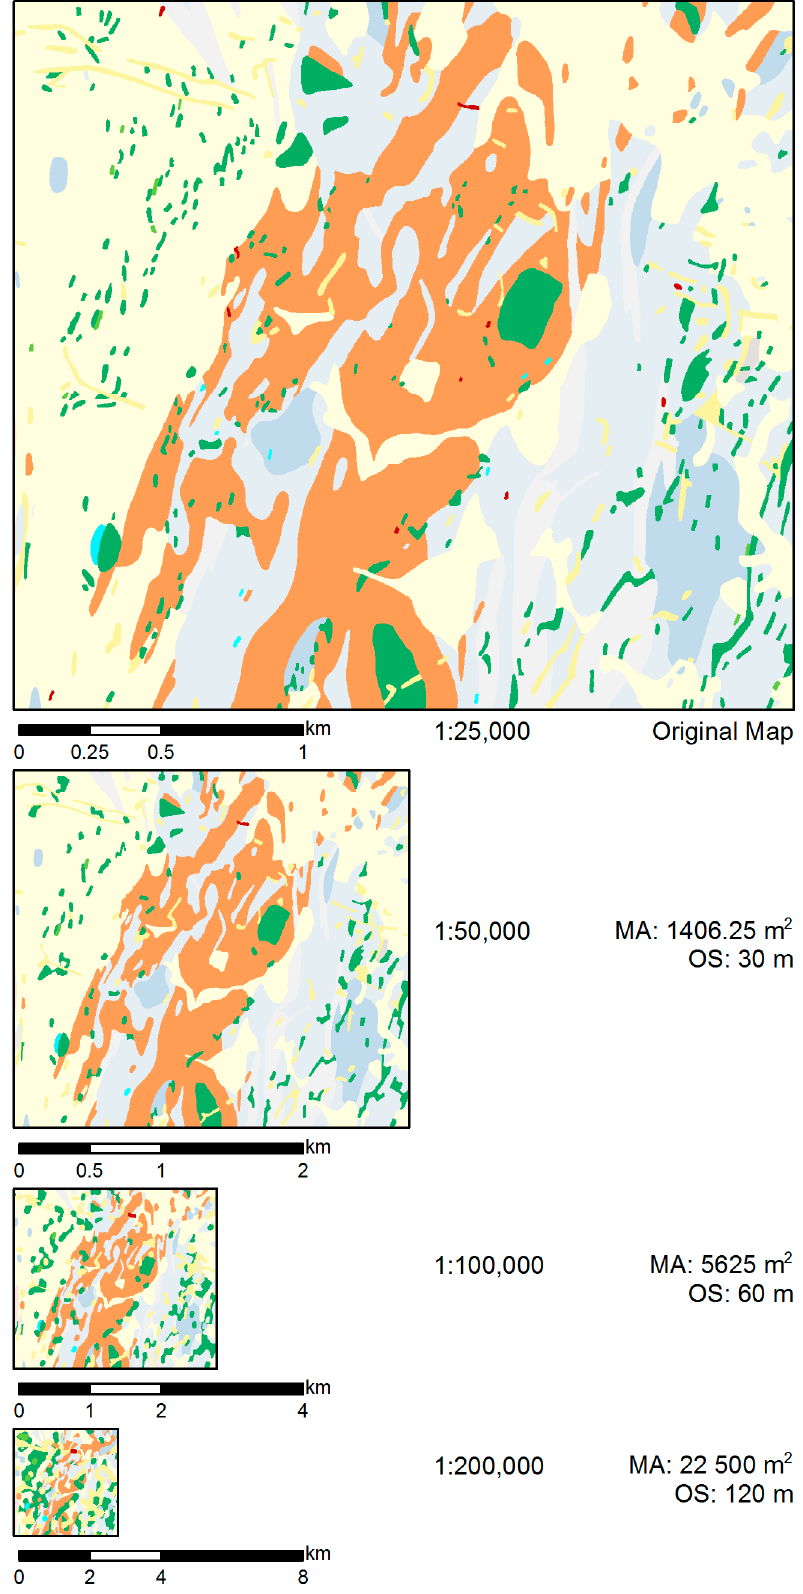
Figure 16. Scale series produced using the Compromised set of goal values for the MA and OS constraints.